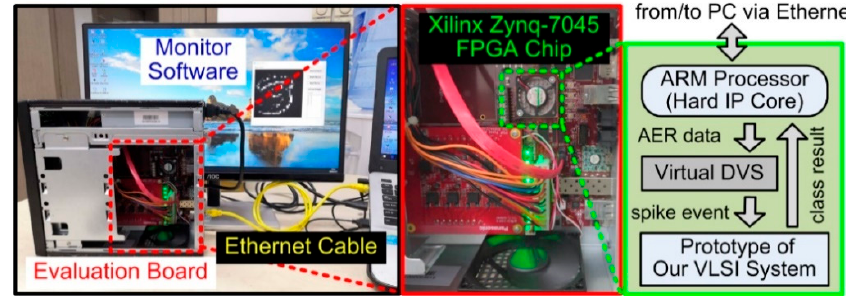
Figure 6. The FPGA prototype of the proposed VLSI system in the evaluation environment.